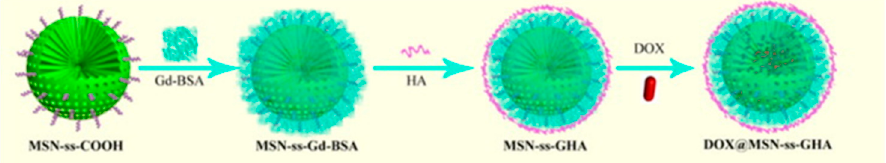
Figure 5. Theranostic redox-responsive mesoporous silica nanoparticles for dual drug delivery and MR imaging. Reprinted (adapted) with permission from [53]—Published by American Chemical Society (ACS) .